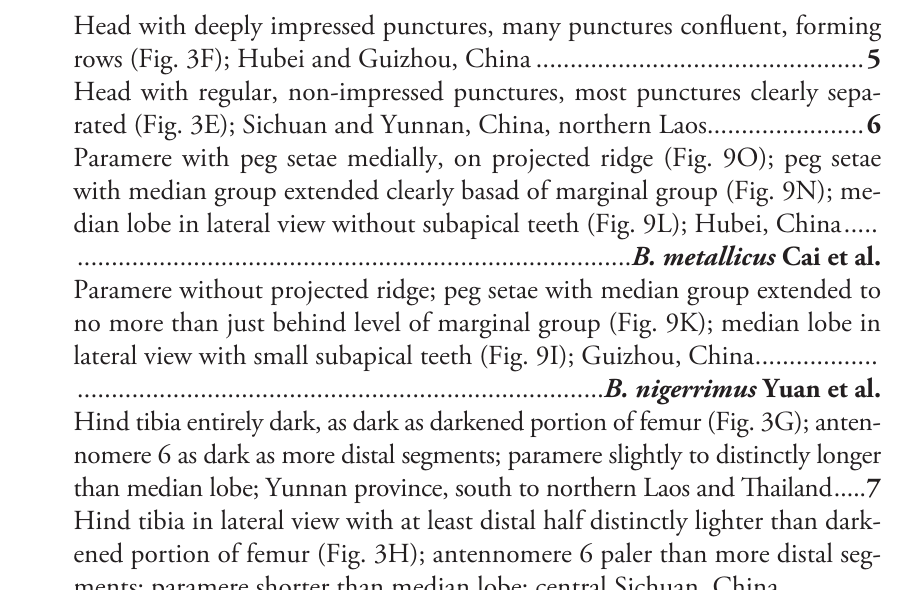
Head with deeply impressed punctures, many punctures confluent, forming rows (Fig. 3F); Hubei and Guizhou, China ................................................ 5 – Head with regular, non-impressed punctures, most punctures clearly sepa- rated (Fig. 3E); Sichuan and Yunnan, China, northern Laos....................... 6 5 Paramere with peg setae medially, on projected ridge (Fig. 9O); peg setae with median group extended clearly basad of marginal group (Fig. 9N); me- dian lobe in lateral view without subapical teeth (Fig. 9L); Hubei, China ..... – Paramere without projected ridge; peg setae with median group extended to no more than just behind level of marginal group (Fig. 9K); median lobe in lateral view with small subapical teeth (Fig. 9I); Guizhou, China .................. 6 Hind tibia entirely dark, as dark as darkened portion of femur (Fig. 3G); anten- nomere 6 as dark as more distal segments; paramere slightly to distinctly longer than median lobe; Yunnan province, south to northern Laos and Thailand ..... 7 – Hind tibia in lateral view with at least distal half distinctly lighter than dark- ened portion of femur (Fig. 3H); antennomere 6 paler than more distal seg- ments; paramere shorter than median lobe; central Sichuan, China .............. 7 Antennomeres 7–10 relatively elongate: 6 quadrate and 7 weakly transverse (Fig. 4A); paramere with attenuate apex (Fig. 8A, D, E) ............................. 8 – Antennomeres 7–10 relatively transverse: 6 weakly, and 7 distinctly trans- verse (Fig. 4B); paramere with evenly converging sides (Fig. 8J,K) .............. 9 8 Apex of median lobe in lateral view forming a more elongate triangle (Fig. 8B); paramere in lateral view with broad lateral projection (Fig. 8F); Central Yun- – Apex of median lobe in lateral view forming a shorter triangle (Fig. 8C); para- mere in lateral view with sharp lateral projection (Fig. 8G); Western Yunnan, 9 Peg setae absent from broad oval shaped area along middle of paramere (Fig. 8O); median lobe in lateral view without expansion (Fig. 8N); Western – Peg setae absent from only narrow strip along middle of paramere (Fig. 8K); median lobe in lateral view with distinct expansion (as in Fig. 8B); southeast Yunnan, China, and northern Laos (possibly northern Thailand) ................. 10 Head dark with frons distinctly paler, light orange (Fig. 1C, E) ................ 11 – Frons similar in color to rest of head (as in Fig. 1F) .................................. 16 11 Pronotal margin greatly expanded, at its widest point, more than four lateral puncture widths wide (Fig. 4C); large species, forebody length 5.2–6.5 mm .... – Pronotal margin slightly to moderately expanded, at its widest point, no more than three lateral puncture widths wide (Fig. 4D); smaller species,